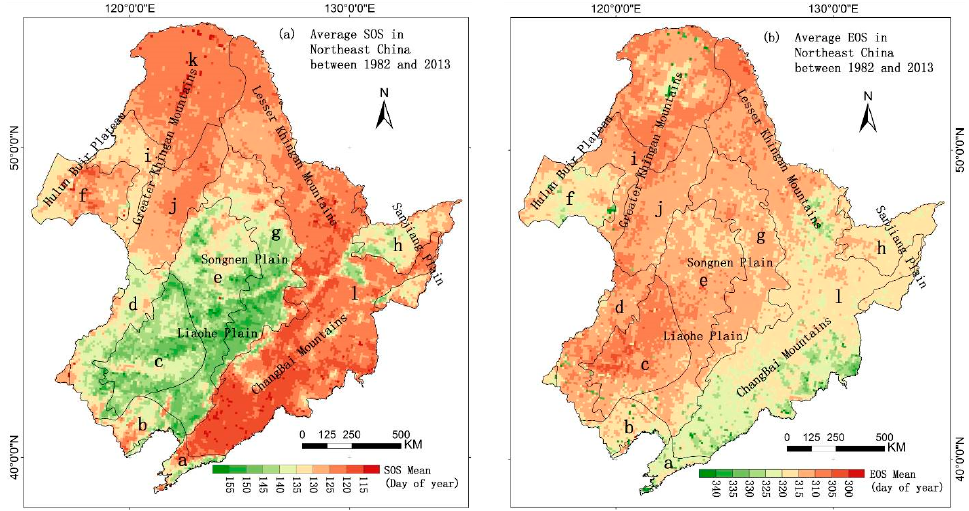
Figure 2. Average SOS (start of the growing season) ( a ) and EOS (end of the growing season) ( b ) dates in Northeast China between 1982 and 2013.